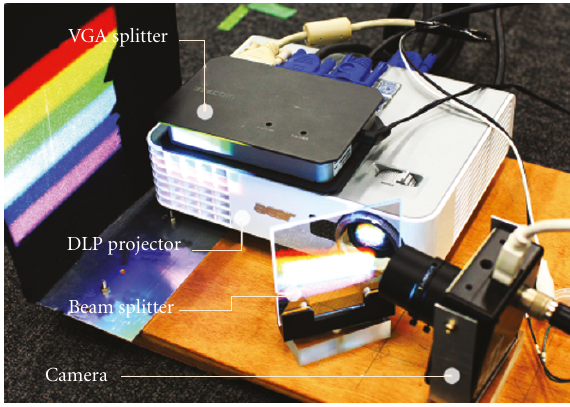
Figure 2: Overall system